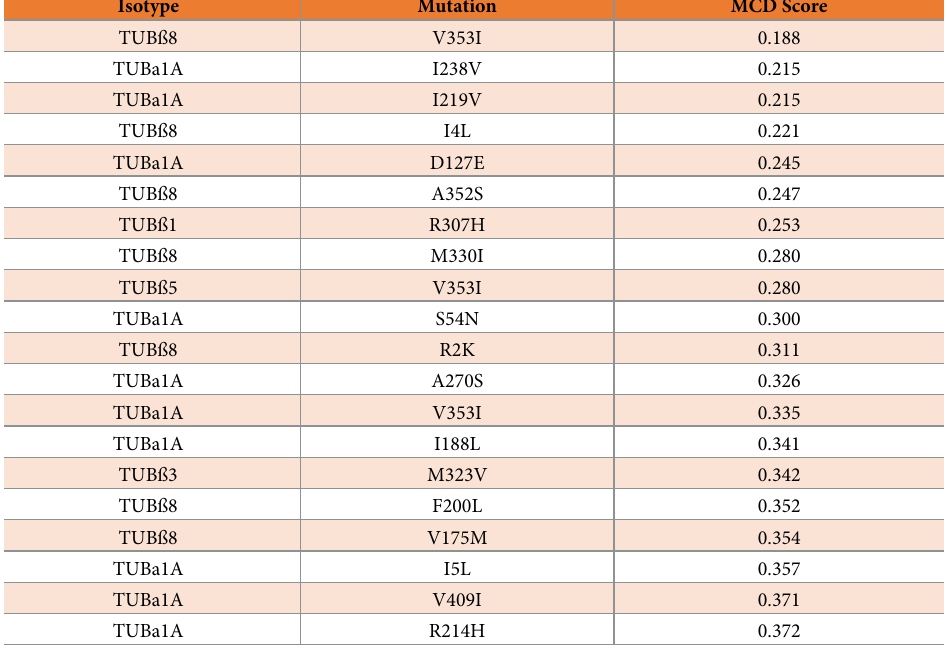
Table 2. The most poorly predicted pathogenic tubulin mutations. For each of the VEPs used in this study, cumula- tive distribution ranks were generated in a combined dataset of putatively benign and pathogenic tubulin variants. MCD scores for each variant were calculated by averaging the ranks from each predictor. Pathogenic variants with the lowest MCD scores are shown here, representing those most poorly predicted by VEPs.